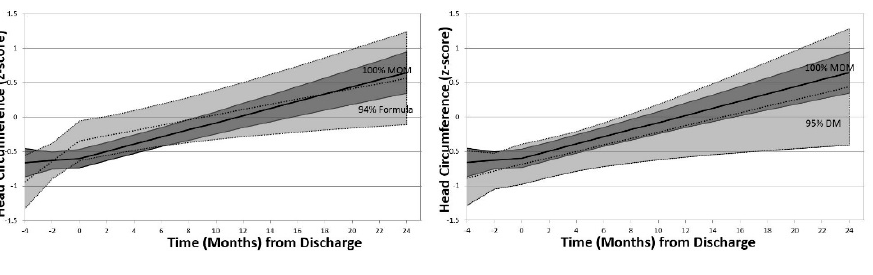
Figure 1. Model estimated anthropometric ( z -score) changes over time comparing infants at 100% MOM feeds to infants at 95th percentile of cohort for formula or DM feeds. DM: Donor milk; HC: Head circumference. Mean z -score: Central solid (MOM) and dotted (formula or DM) lines; 95th% confidence intervals: Shaded areas (dark grey MOM, light grey formula or DM) bordered by solid (MOM) and dotted (formula or DM) lines.